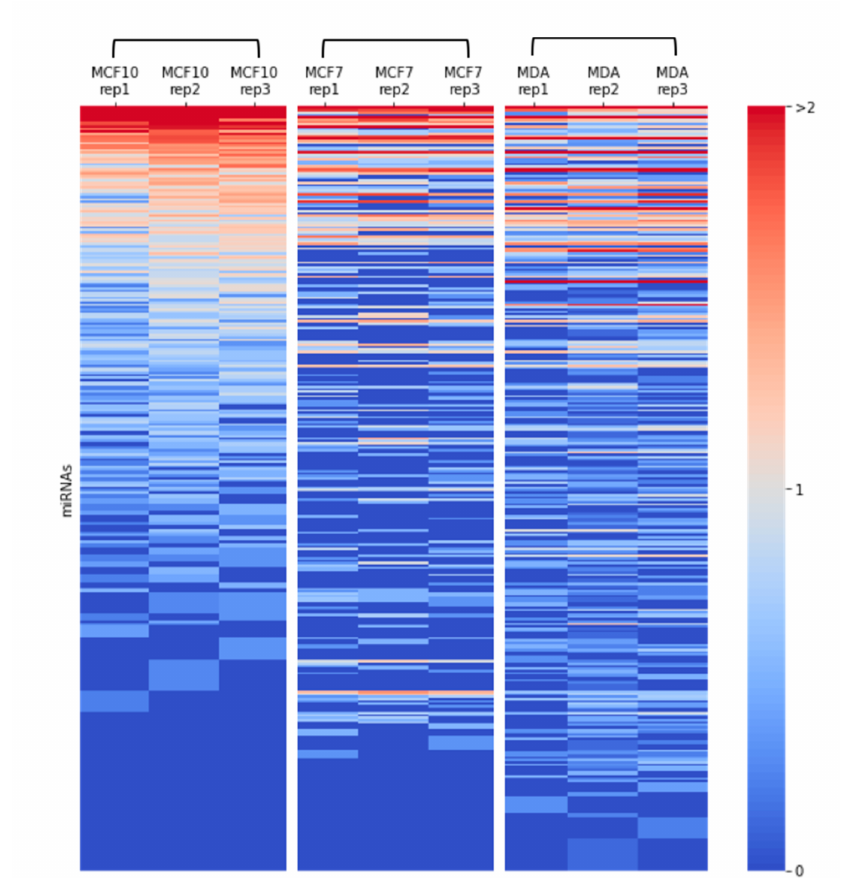
Figure 2. Heatmap of miRNA expression in breast cancer cells. Expression of SF-miRNAs in triplicates from each of the breast cancer cell-lines: MCF-10A, MCF-7, and MDA-MB-231, are presented. Color code represents the amount of reads in a logarithmic scale (log10). All miRNAs that are analyzed have ≥ 10 reads in any specific cell type, a minimal read length of ≥ 17. The data source is in Supplemental Table